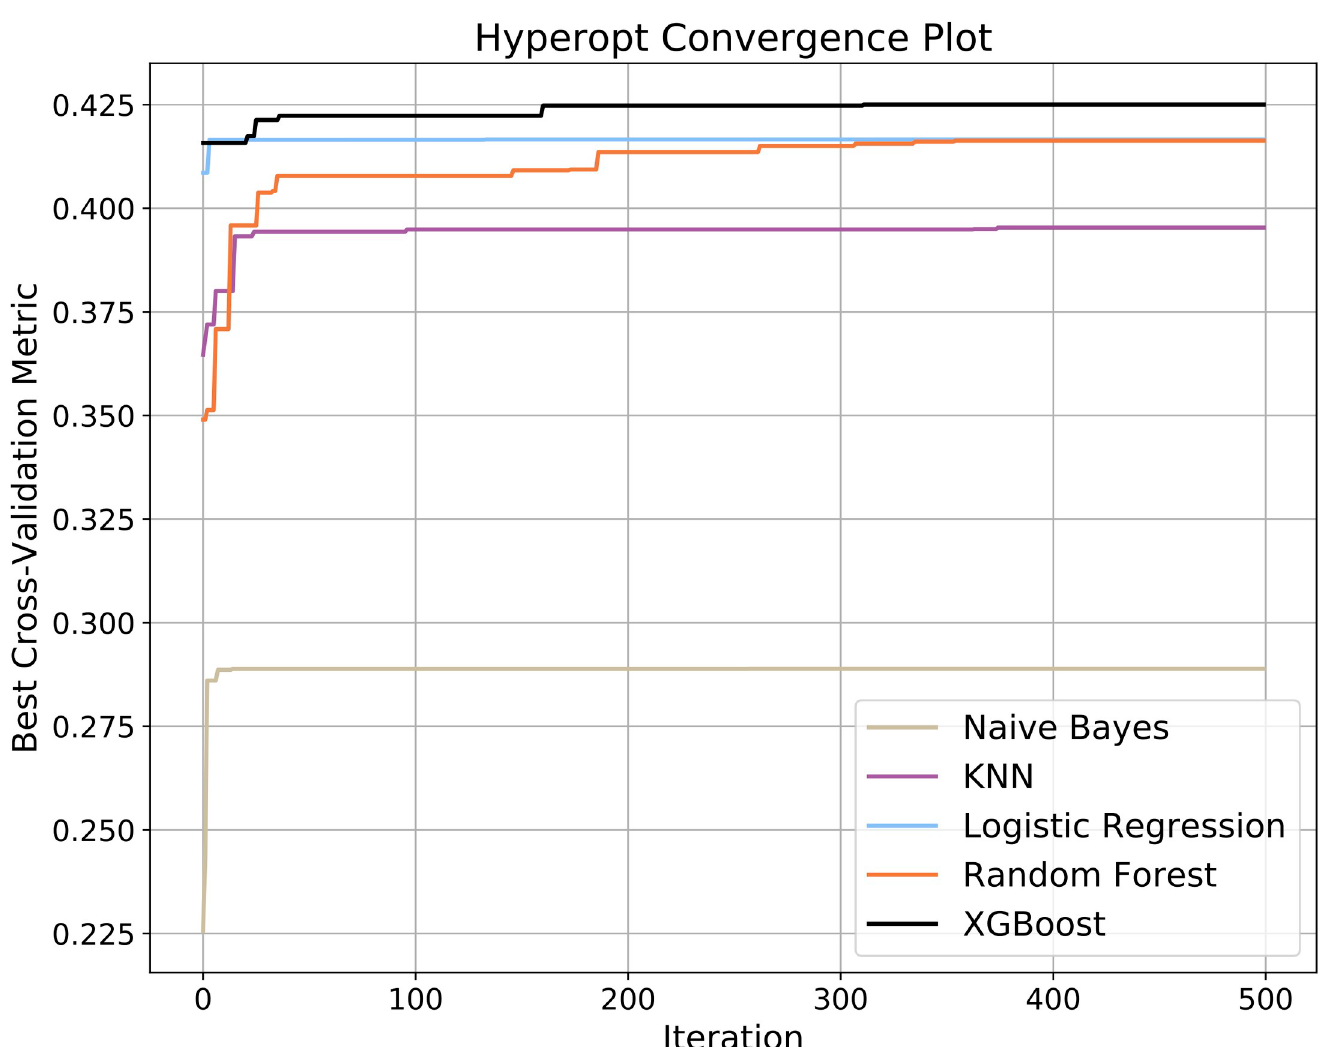
Fig 3. Hyperparameter convergence. HyperOpt iteratively chooses candidate hyperparameter combinations from a large hyperparameter space based on model performance on the prior iteration. The plot represents the highest performance up to a given iteration. For the ML algorithms in this study, there was no performance improvement after the 300 th